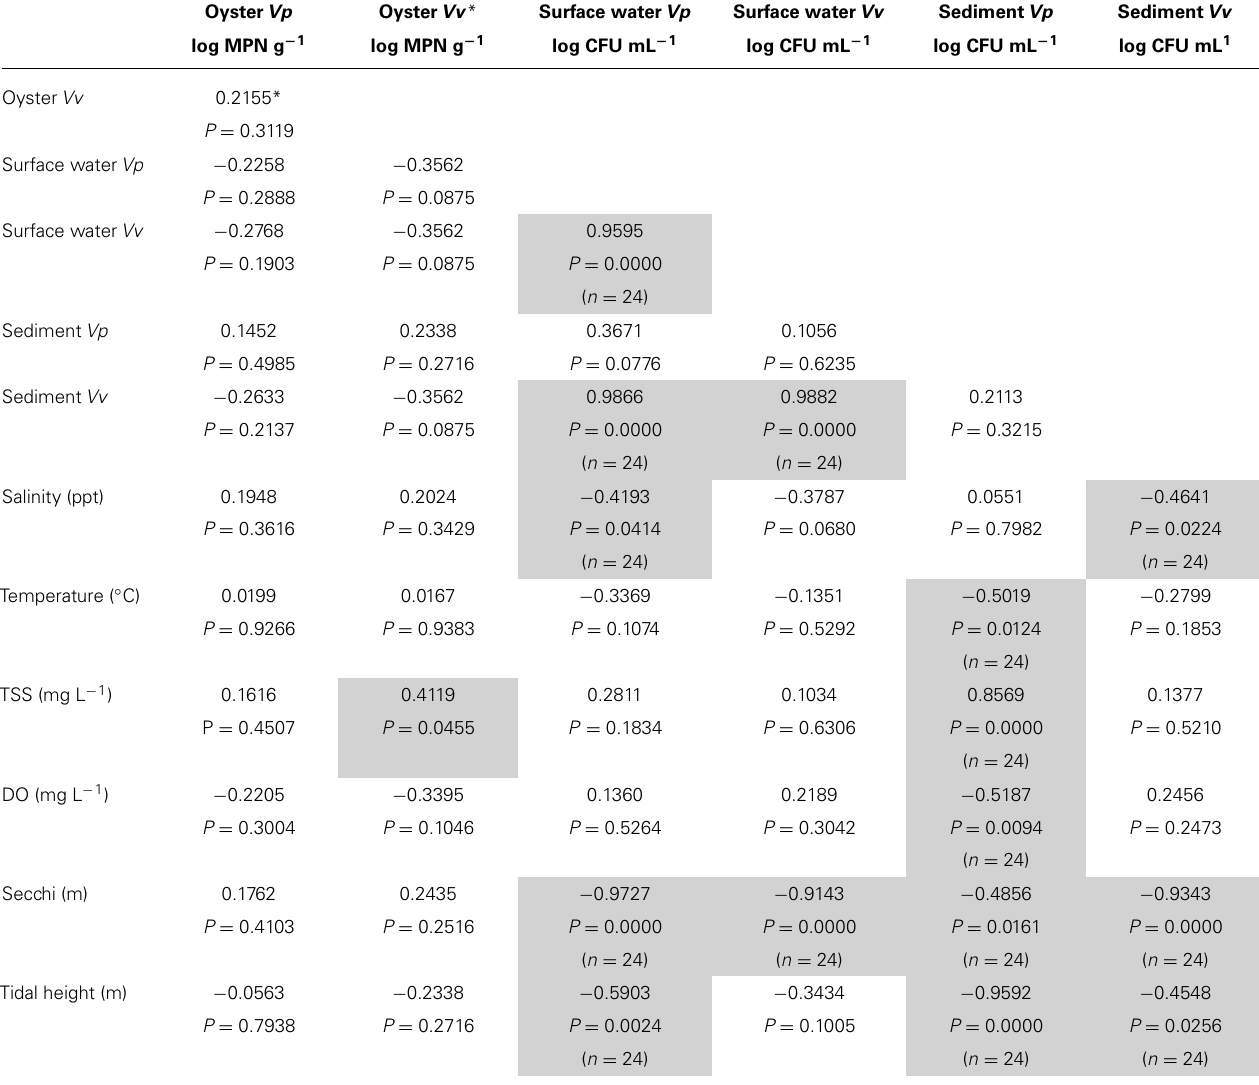
Table 1 | Correlation table of environmental parameters and Vibrio concentrations in oysters, sediment and surface